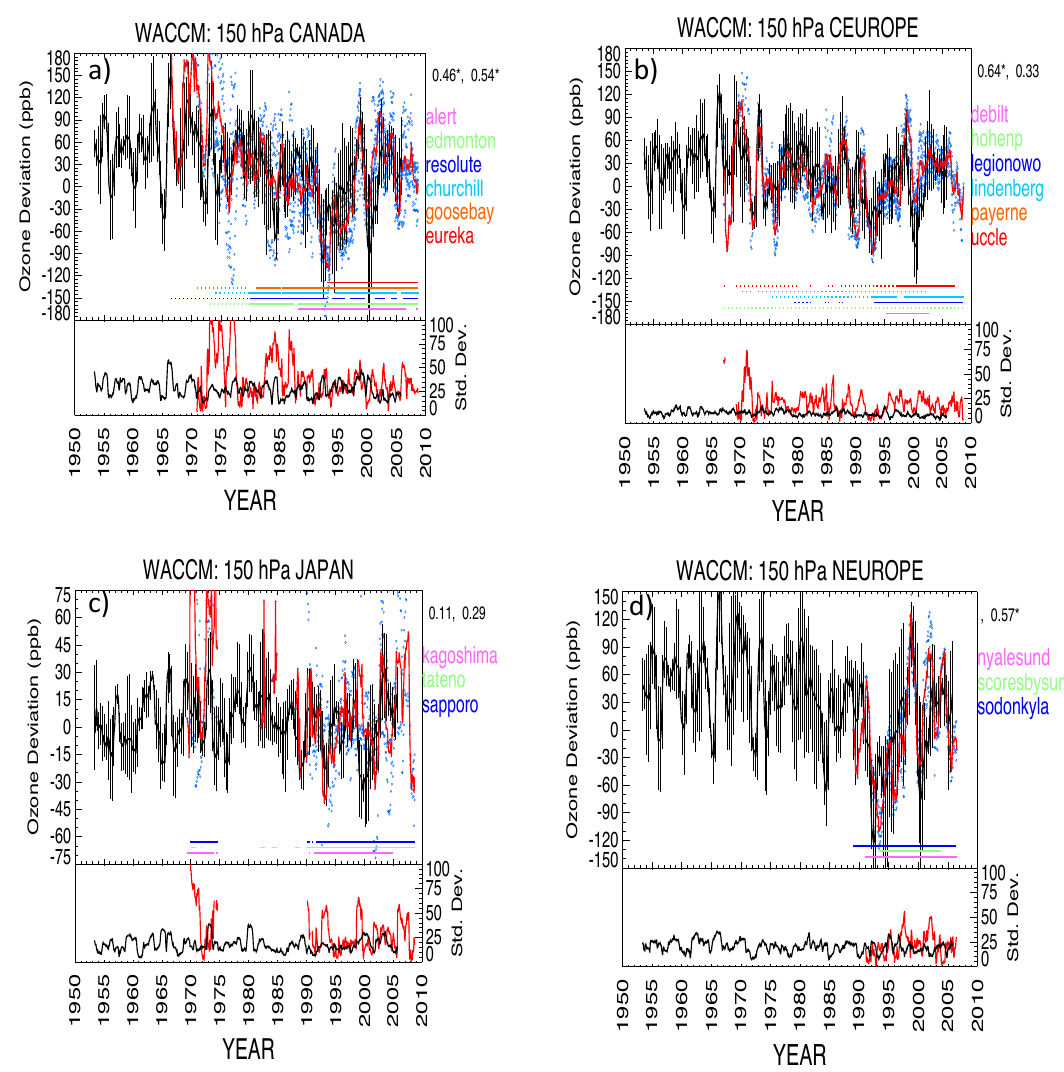
Figure 3. Simulated and measured ozone deviations (ppb) at 150hPa averaged over the (a) Canadian ozonesonde sites, (b) the central European ozonesonde sites, (c) the Japanese ozonesonde sites and (d) the northern European ozonesonde sites. The simulated ensemble average is given as the bold black line, the thin black lines bracket the maximum and minimum ensemble ozone deviation, the measured average is given as the red line, the blue dots give the measured ozone deviation for each site comprising the regional average. Colored bars indicate when each measurement site (color coded as indicated on right) made sufficient measurements to calculate an annual ozone concentration: solid lines indicate an ECC or KC measurement and dotted lines a Brewer–Mast ozonesonde measurement. The black and red lines at the bottom give the simulated (black) and measured (red) standard deviation of ozone (ppb) calculated across all sites within each region. Numbers in the upper right give the model–measurement correlation of the average ozone within each region prior to 1990 (left) and after 1990 (right). Correlations use detrended data. Significant correlations at the 95% level are starred. Monthly ozone deviations are smoothed over 12 months. Deviations are from ozone averaged 1 January 1990–31 December 1994. The simulated ozone record uses monthly averaged output at each measurement site throughout the simulation with no attempt to duplicate the actual temporal sampling of the